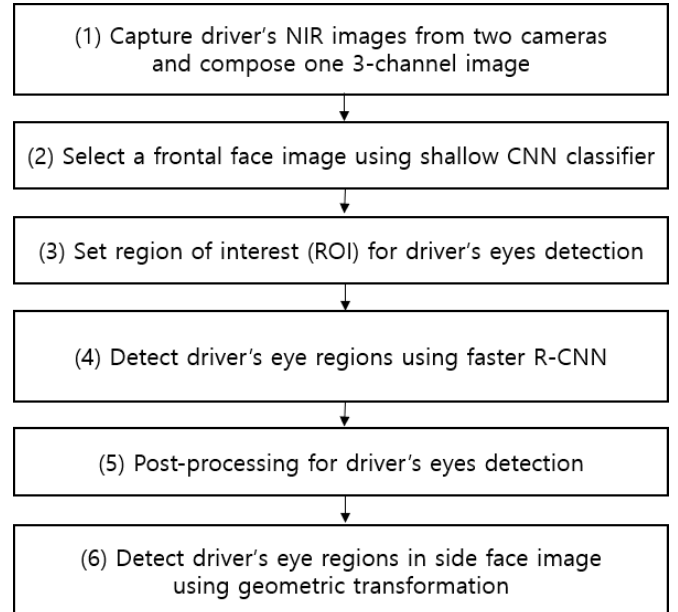
Figure 1. Flowchart of the proposed system.